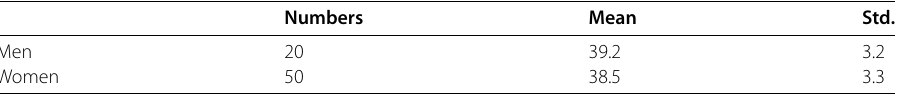
Table 1 Descriptive statistics (mean and standard deviation values) of the study participants’